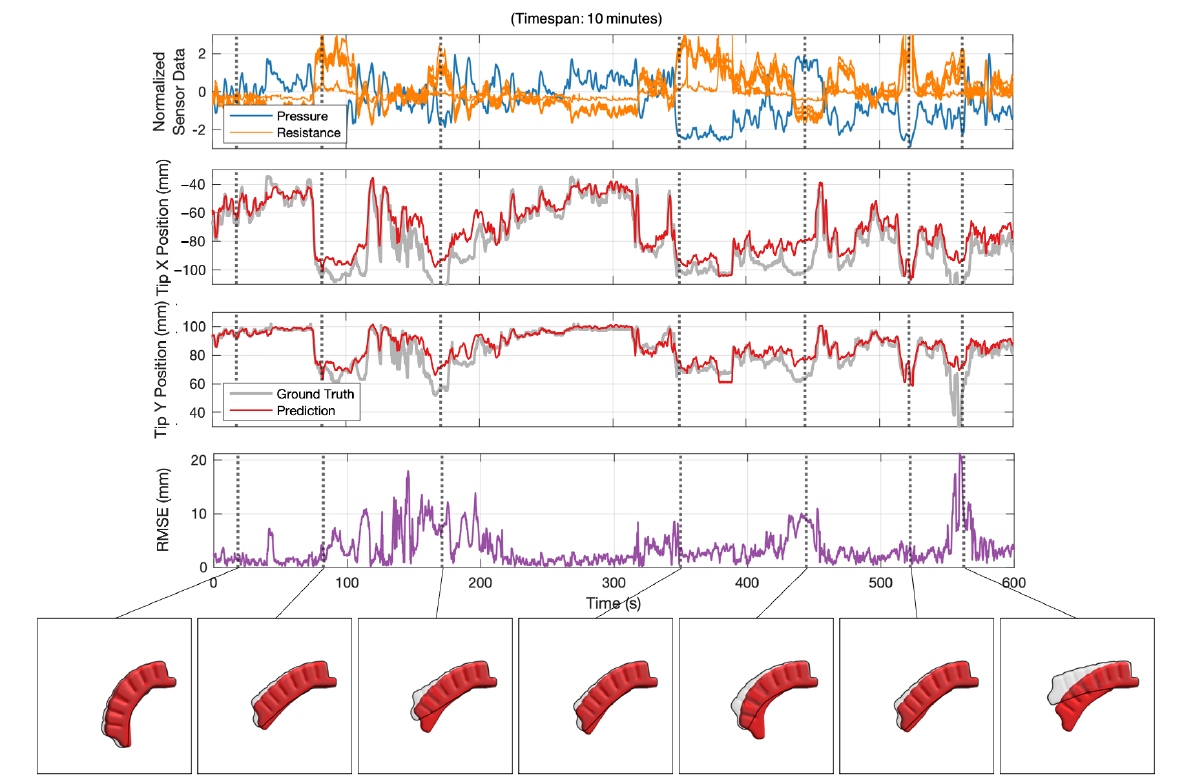
Figure 3. The entire 10 min of the test dataset is shown along with predictions from the BiLSTM model and snapshots of the resulting poses. The top row depicts the raw sensor data, showing both the single pressure sensor and the suite of resistances. The second and third rows show only the fingertip horizontal (X) and vertical (Y) positions. The fourth row is a plot of the root mean squared error across all the LED positions. The insets below depict the overall pose of the robot during seven moments in which the pose estimator was performing maximally or minimally